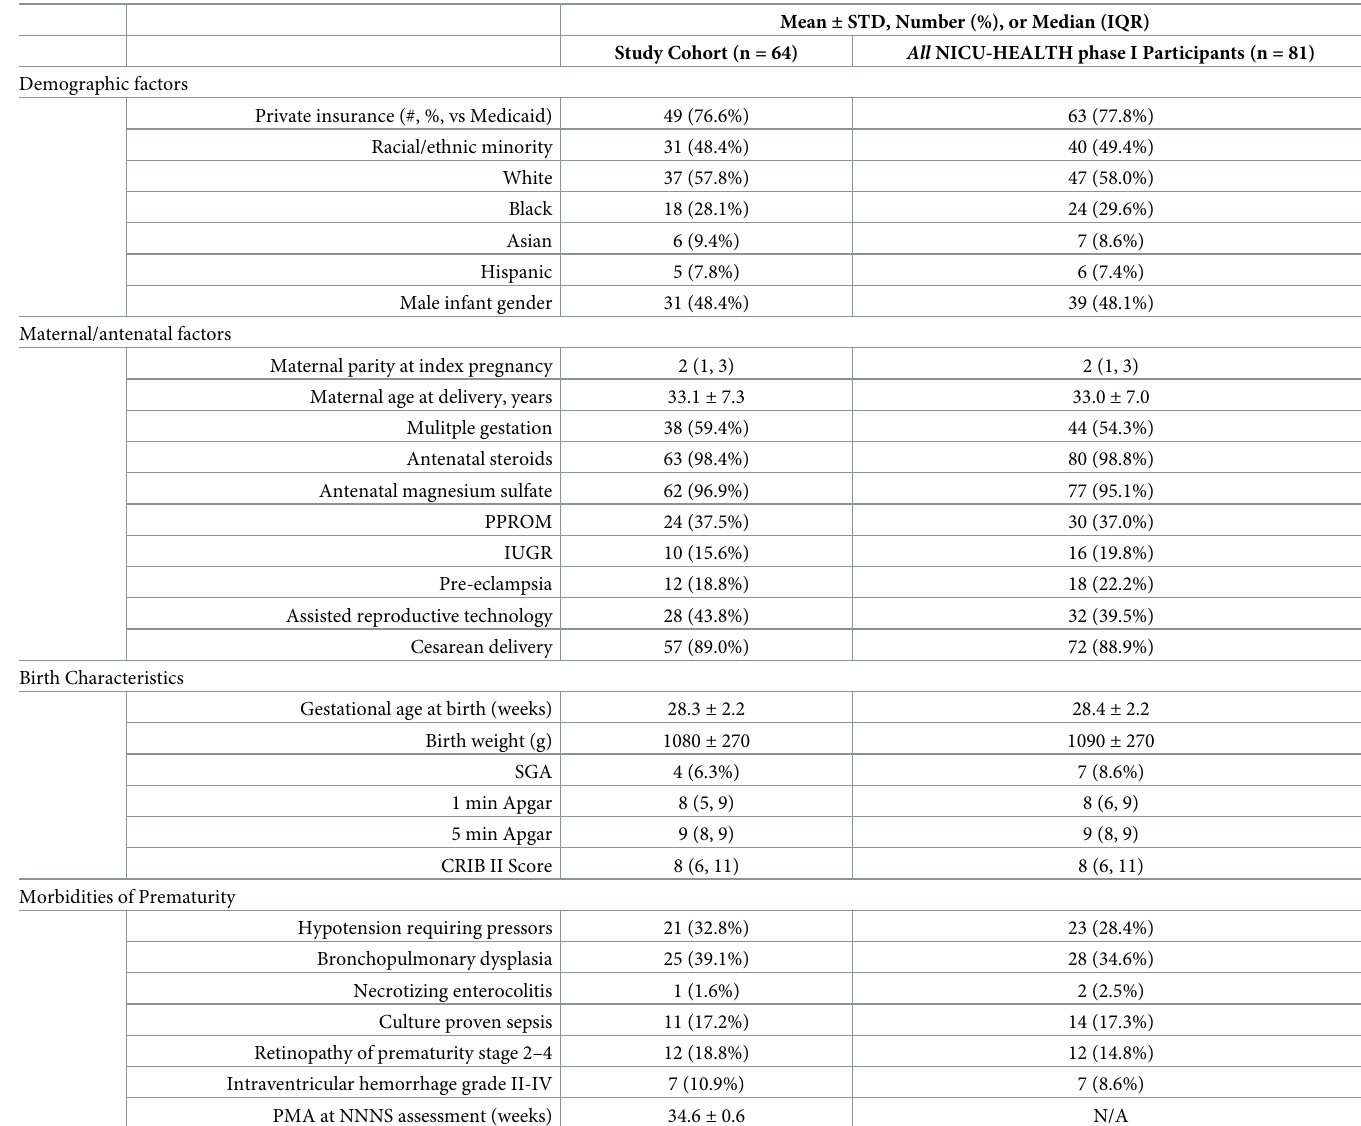
Table 2. Demographic characteristics of participating